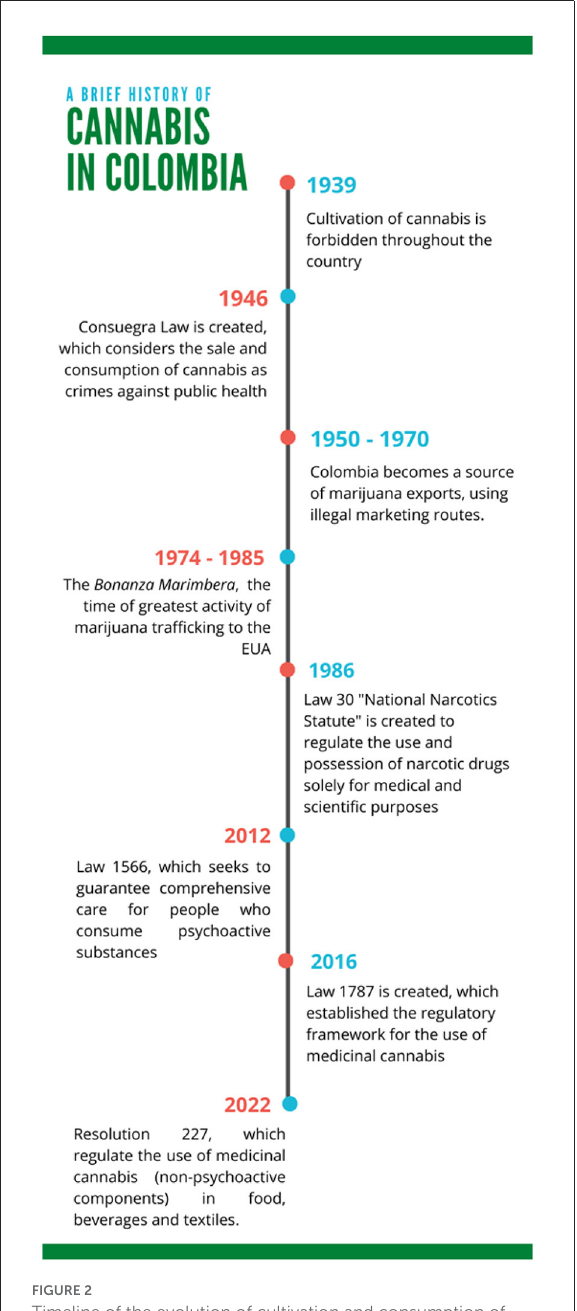
FIGURE2 Timeline of the evolution of cultivation and consumption of cannabis in Colombia.